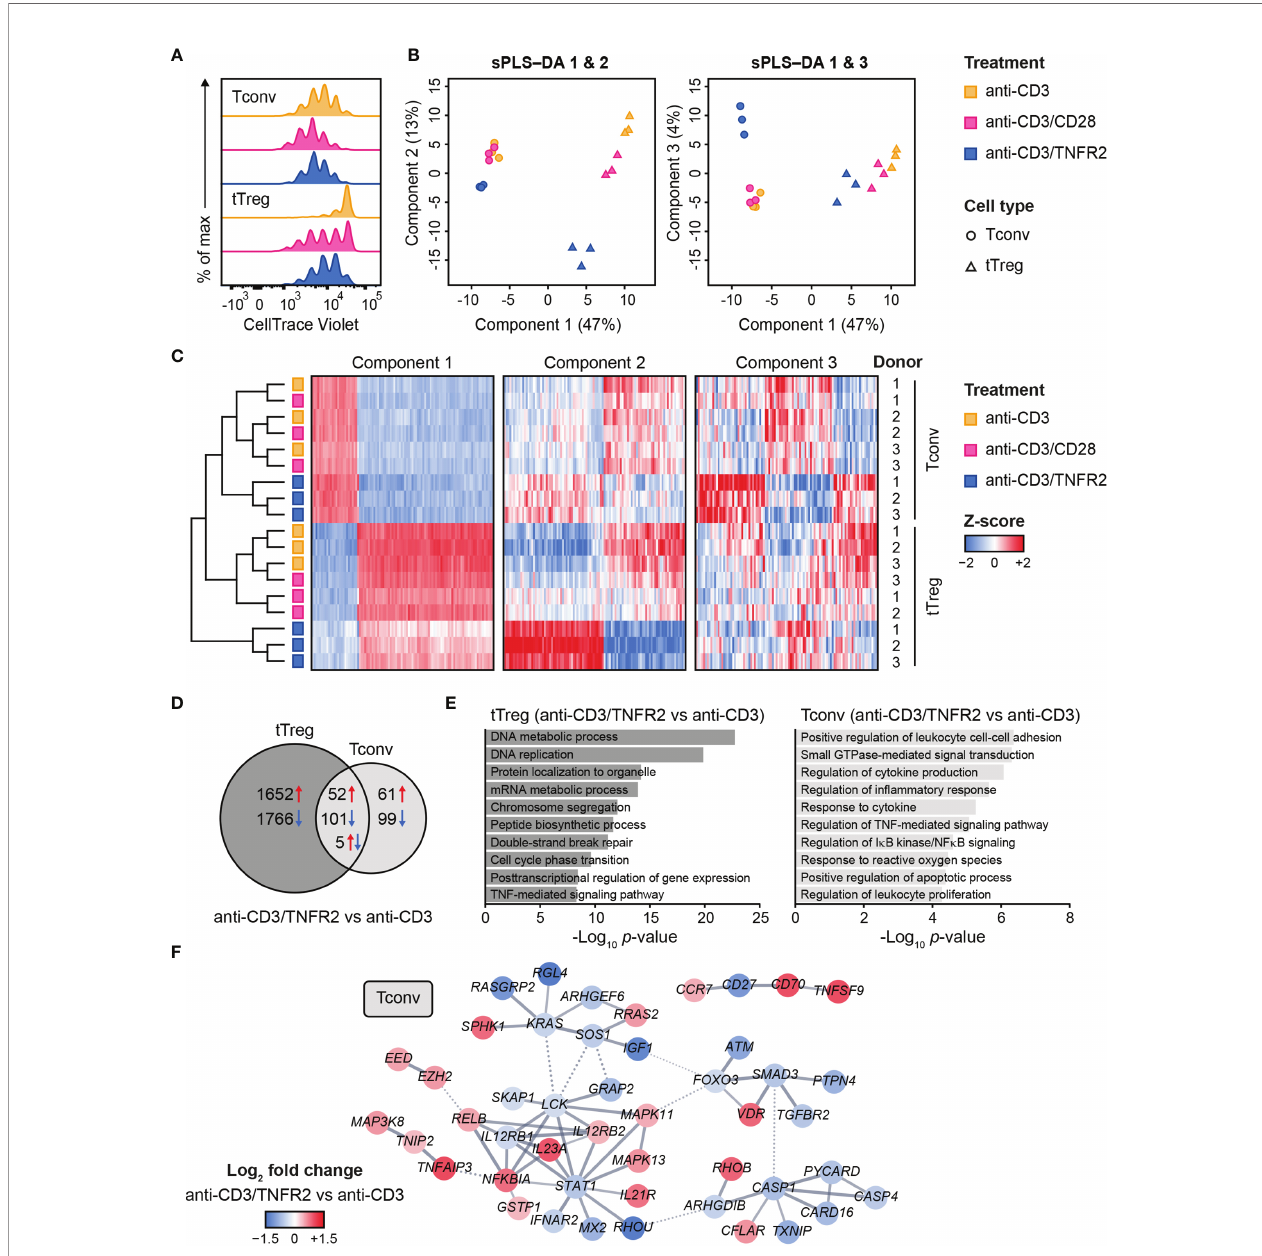
FIGURE 1 | Transcriptome analysis of human Tconvs and tTregs highlights distinct responses upon CD3, CD3/CD28 or CD3/TNFR2 stimulation. (A) Tconvs and tTregs were sorted and pre-expanded for 2 weeks, then labeled with CellTrace Violet and restimulated for 96 h to assess cell proliferation by fl ow cytometry. For color legend of stimuli, see panel (B) Tconvs and tTregs were sorted and pre-expanded for 2 weeks, restimulated as indicated for 24 h and subjected to transcriptomics. sPLS – DA shows clustering of indicated sample groups by components 1 – 3. (C) Representative heat map of the sPLS – DA results, showing hierarchical clustering of indicated sample groups and relative expression levels (color-coded z-scores) of the top 100 transcripts per component 1 – 3. (D) Venn diagram depicting the number of up- (red) and downregulated (blue) transcripts in CD3/TNFR2- versus CD3-stimulated cells, including unique and shared changes in tTregs and Tconvs ( p < 0.05, log 2 fold change > 0.32 or < -0.32). (E) GO Biological Process enrichment analysis of the differentially expressed genes shown in (D) . (F) STRING network of genes involved in the enriched processes for Tconvs in (E) , only including genes with high-con fi dence associations. Markov Cluster Algorithm (MCL) clustering (82) was performed and inter-cluster associations are displayed as dotted lines. Genes were colored based on log 2 fold change. Further details are described in the Supplementary Methods